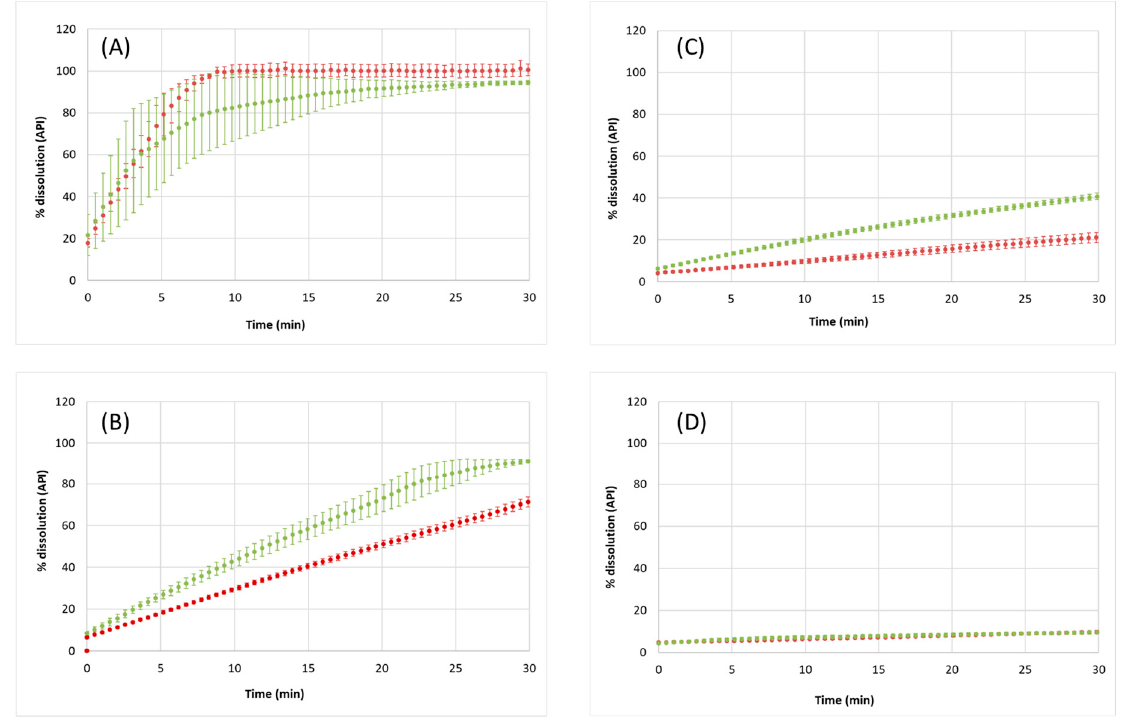
Figure 5. Dissolution profiles of Norfloxacin (•) and Norfloxacin–resorcinol cocrystal (•) at different pH values: pH 2.0 ( A ); pH 4.0 ( B ); pH 5.5 ( C ), and pH 7.4 ( D ). Table 1. Percentage of dissolution and dissolution rate ( μ g min − 1 ) of Norfloxacin and Norfloxacin– resorcinol cocrystal at different GIT pH values. Standard deviations are given in brackets.